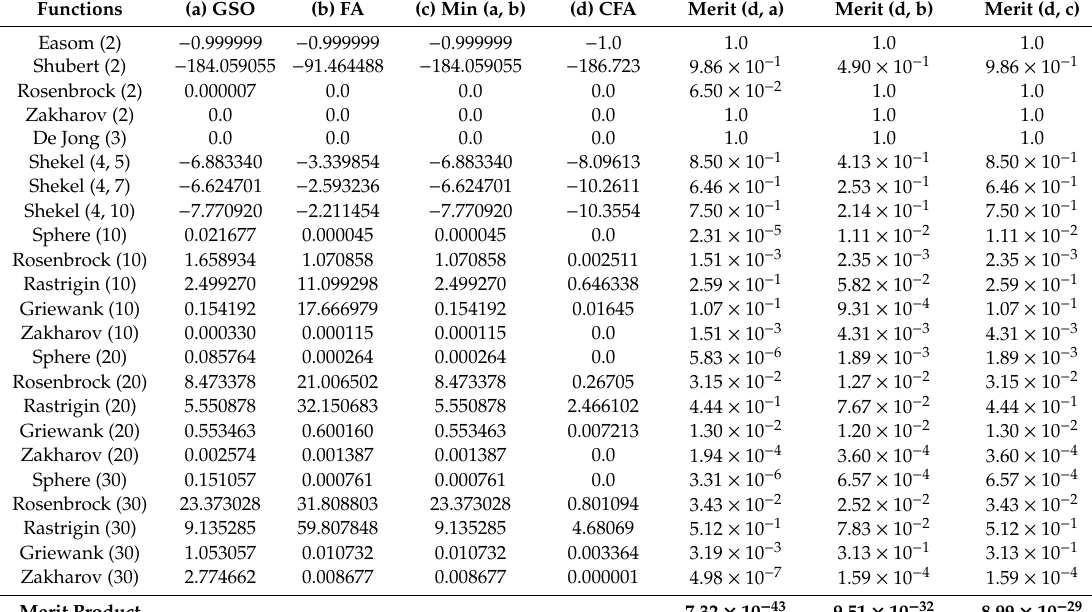
Table 7. The performance comparison between the CFA and its